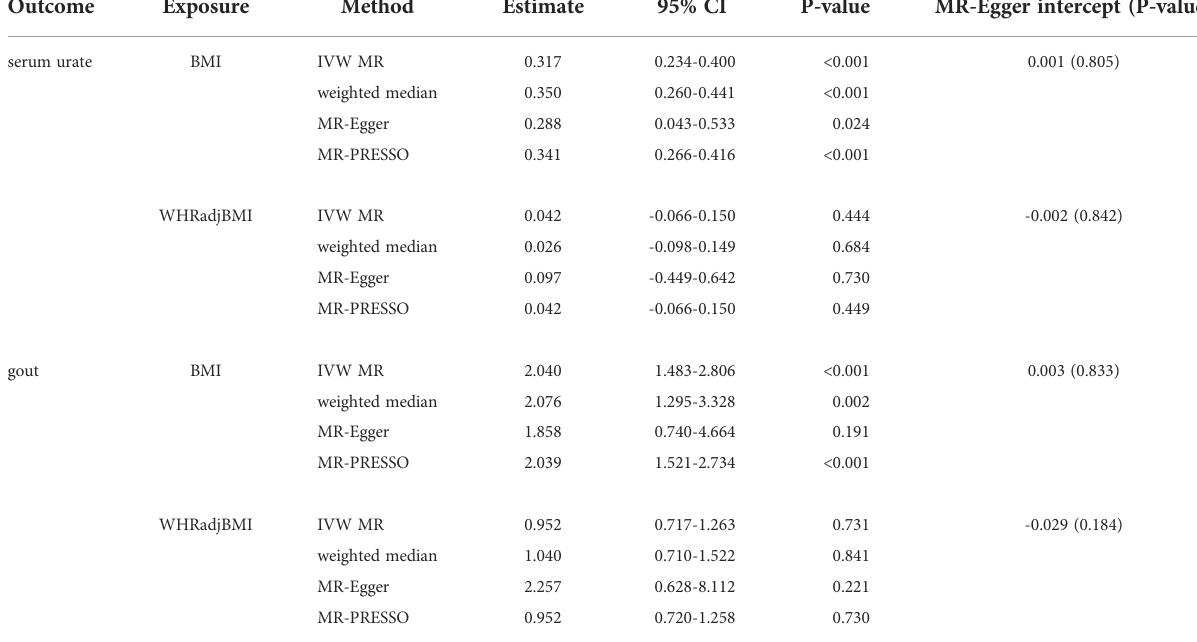
TABLE 3 Mendelian randomization estimates of obesity on serum urate or gout.